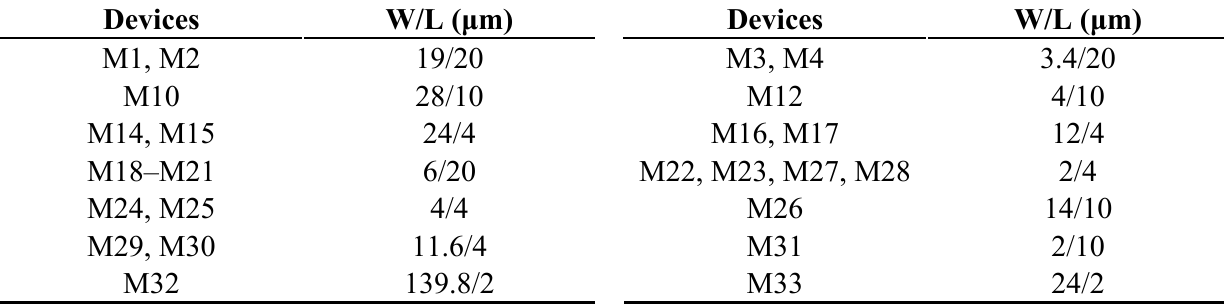
Table 2. Transistor dimensions of the control amplifier.